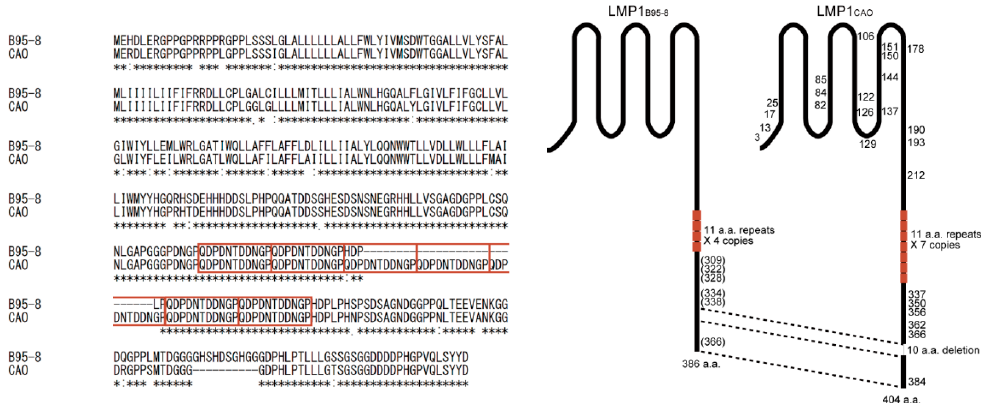
Figure 1. Comparison of the amino acid sequences of B95-8 LMP1 (LMP1 B95-8 ) and CAO-LMP1 (LMP1 CAO ). Sequence alignment was performed by CLUSTALW ( left ); schematic illustrations of the LMP1 domains ( right ). The amino acids in LMP1 CAO that differ from those in LMP1 B95-8 are shown. Note that LMP1 CAO contains three additional copies of 11 amino acid repeats (indicated by brown squares) and a 10 amino acid deletion in the C-terminal cytoplasmic domain.